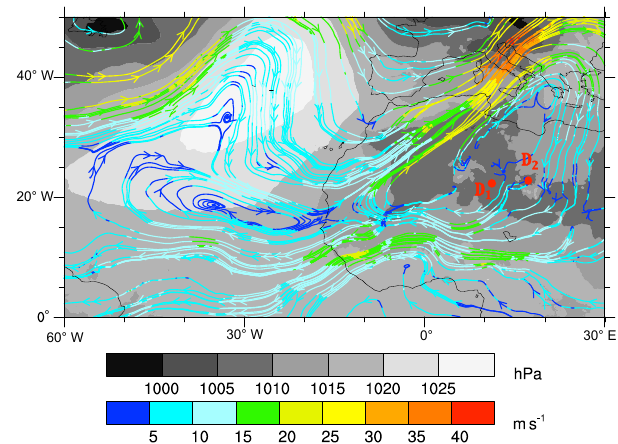
Shown are streamlines coloured by wind speed (scale at bottom), at 600hPa and mean sea level pressure (grey shading) at 00:00UTC on 17 July based on ECMWF operational analyses. The two distur- bances from Fig. 13 are marked in red.